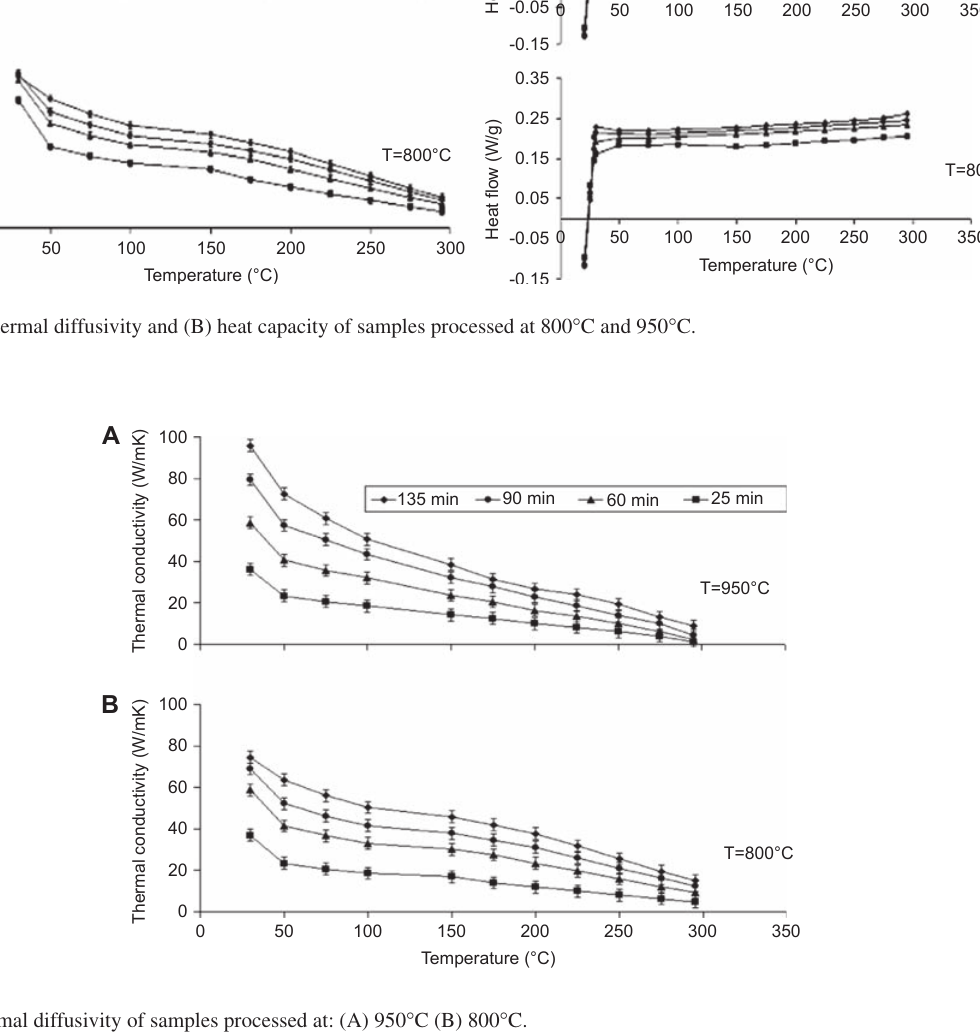
Figure 11 Thermal diffusivity of samples processed at: (A) 950 ° C (B) 800 ° C.